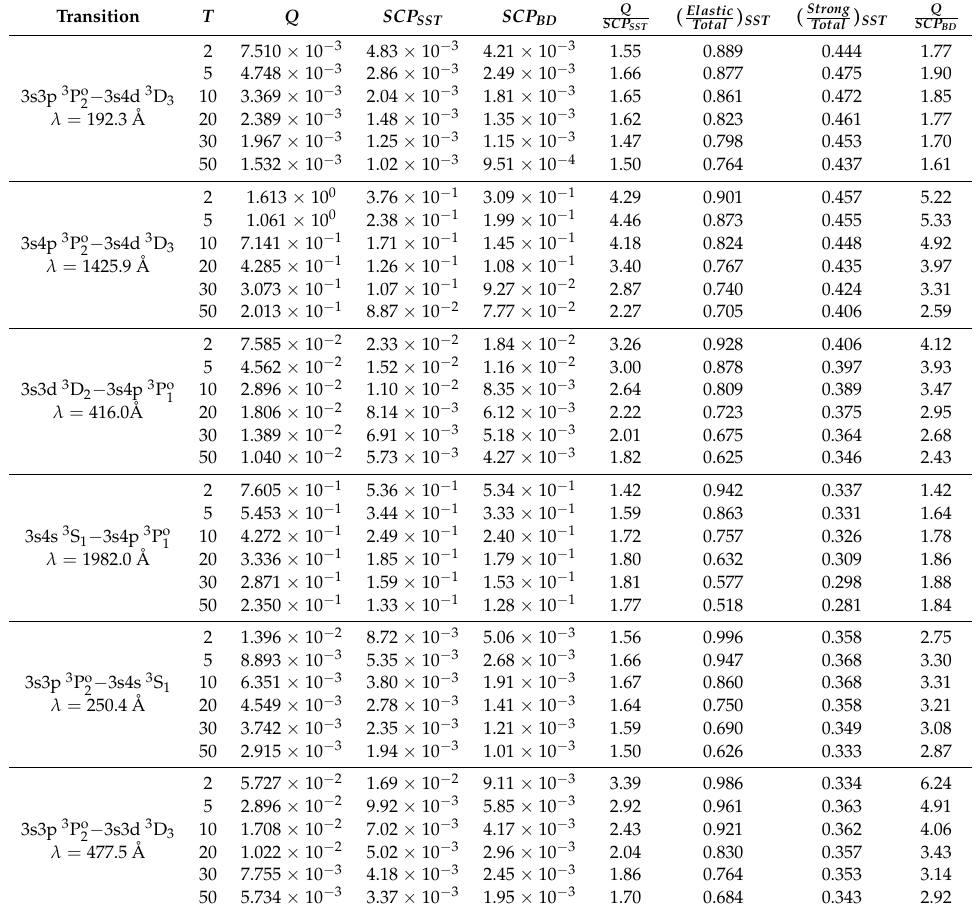
Table 6. Same as in Table 4 but we add the semiclassical results SCP BD obtained in Dimitrijevi´c et al. [12] using the atomic data from Bates and Damgaard [13]. Electron density is N e = 10 18 cm − 3 and T is expressed in 10 4